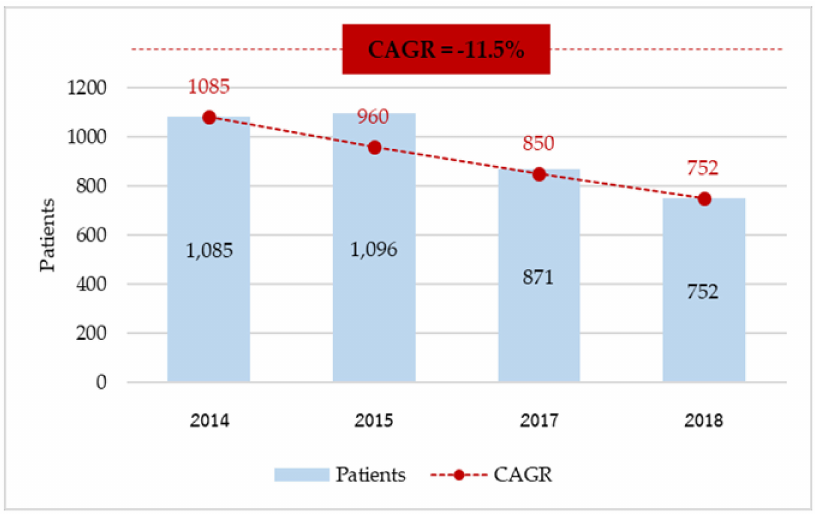
Figure 2. Number of expatriate inpatients in public hospitals in Thailand during